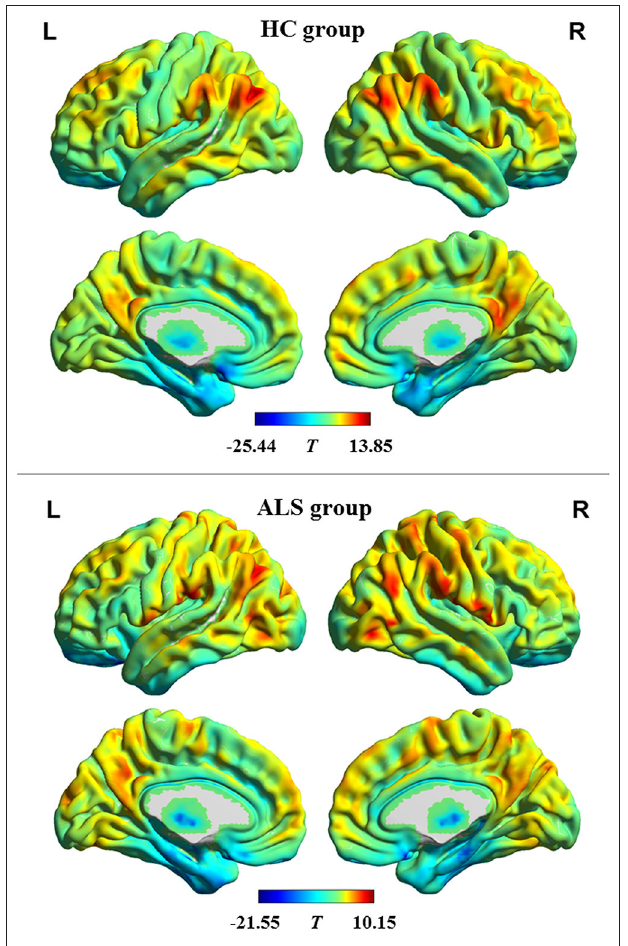
FIGURE 1 | The profile of intrinsic functional stability within each group. The results of one-sample t- tests on functional stability in the resting-state are shown in brain maps of T -values. Red and blue indicate high and low stability, respectively. HC, healthy control; ALS, amyotrophic lateral sclerosis; L, left; R, right.